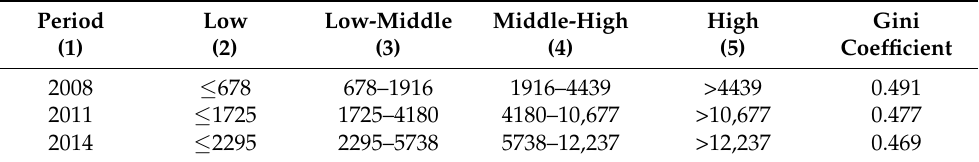
Table 1. Quartile point of per capita income in each